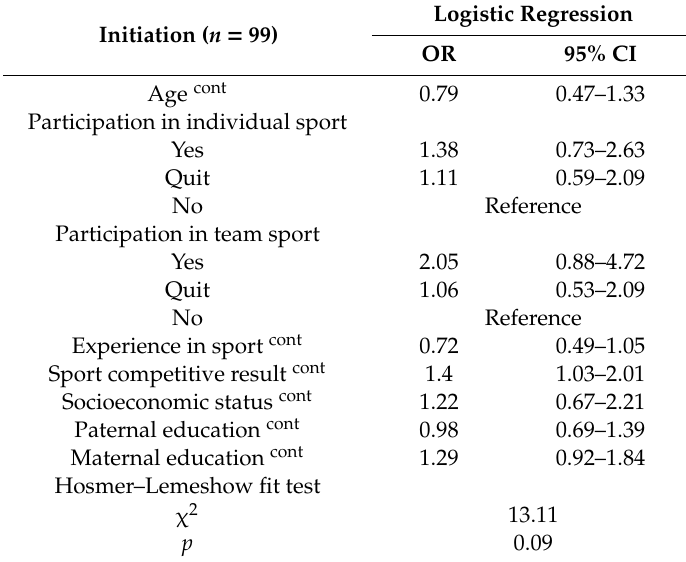
Table 3. Correlates of cannabis misuse initiation during the course of the study (adjusted for gender and urban / rural